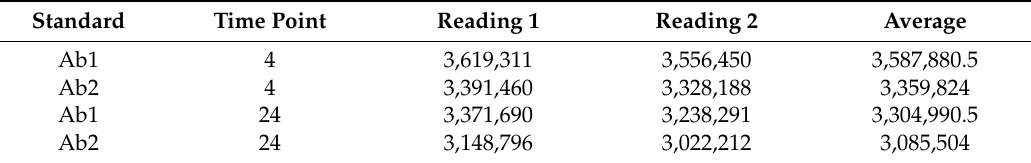
Table 2. CPM for the 111 In-Ab1 and 111 In-Ab2 standards for 4 and 24 h time